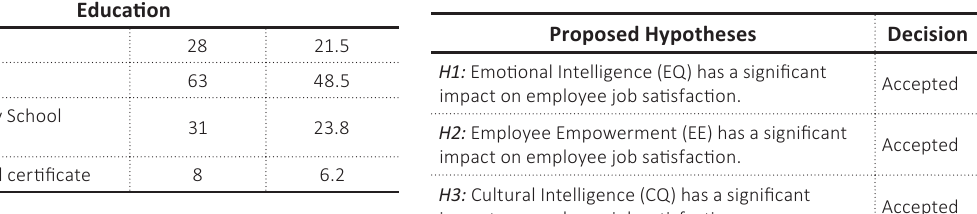
Table 3. Summary of hypotheses